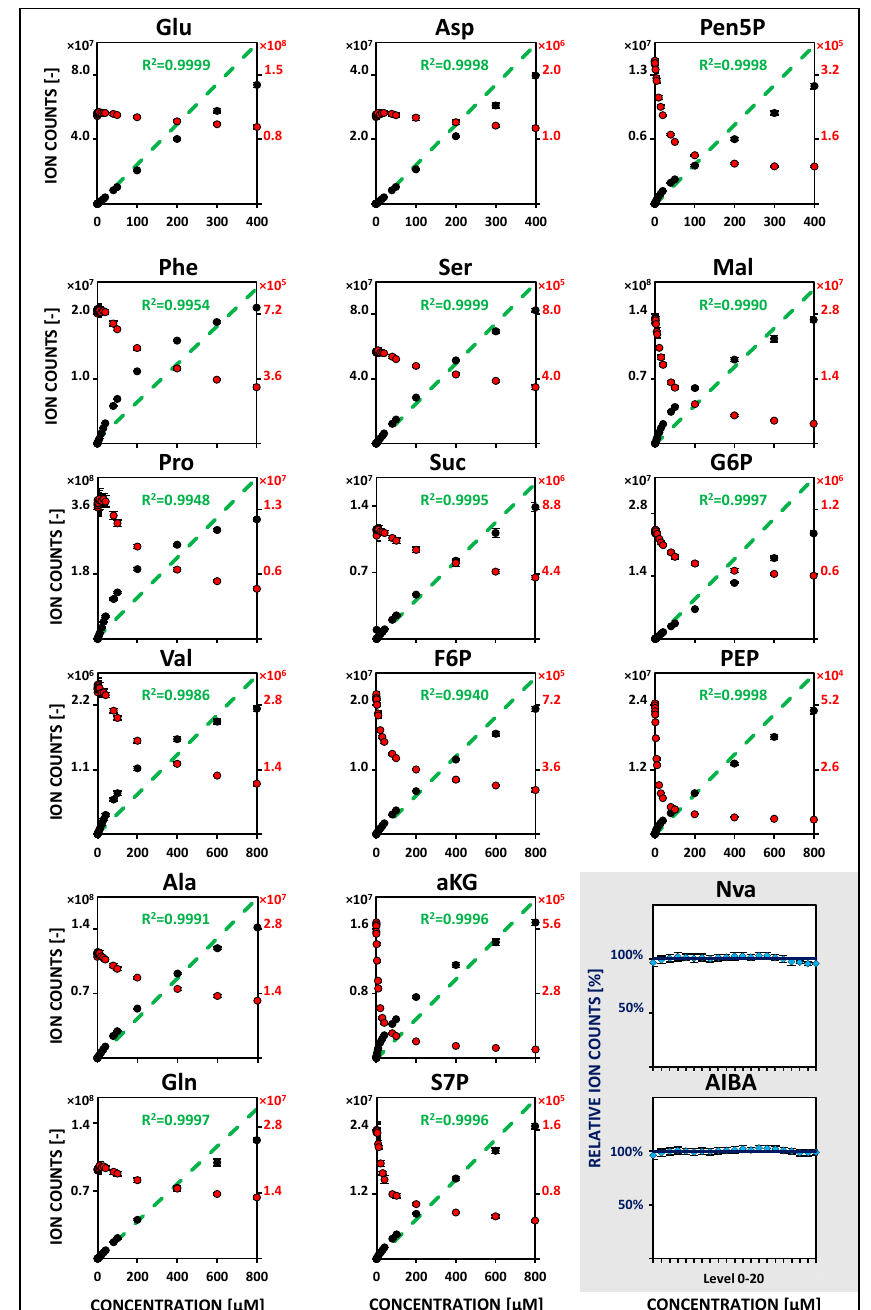
Figure 1. HILIC-based QQQ-MS/MS studies in MRM mode of metabolite-specific signal responsivities using U 13 C isotope dilution (IDMS). Metabolite-specific calibration curves in the extended concentration range (5/10 nM to 400/800 µM, 5 µL sample injection). Mean values of non-labeled reference standards (black) and analogous U 13 C-isotopologues (red) are based on four freshly prepared (24 h) replicates ( n = 4). Linear regression of IDMS normalization (green) is shown with associated correlation coefficients ( R 2 > 0.99). Non-labeled internal standards (blue) are additionally considered for monitoring of instrumental fluctuations ( n = 4). See Table S5 for related regression parameters. See Tables S1–4 for the full names of abbreviated metabolites.